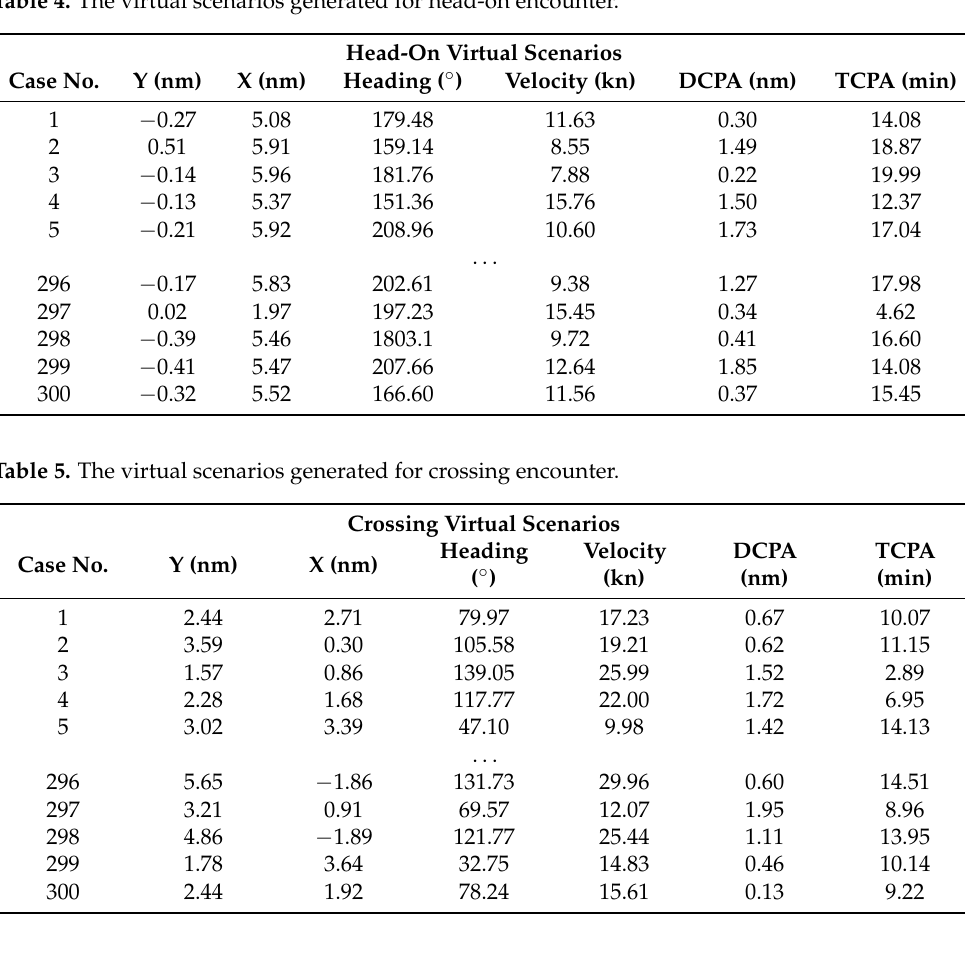
Table 4. The virtual scenarios generated for head-on encounter.